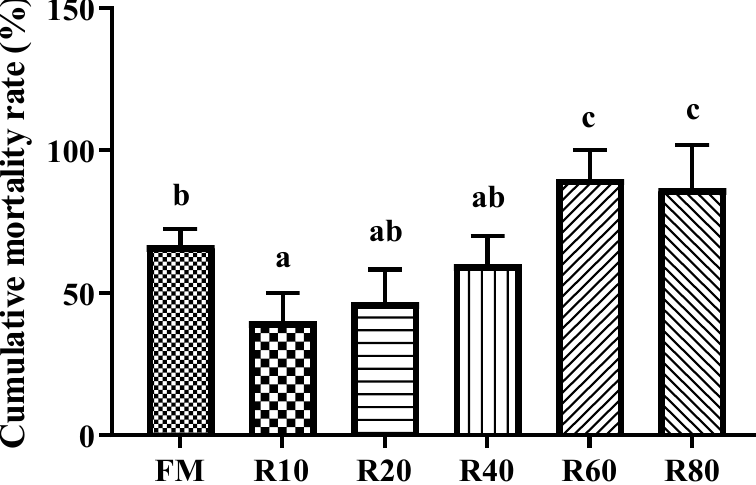
Figure 5. Cumulative mortality rate for juvenile shrimp L. vannamei challenged by V. parahaemolyticus . Data are expressed as means ± SD ( n = 3). Different letters above a bar are statistically significant different among treatments ( p < 0.05).